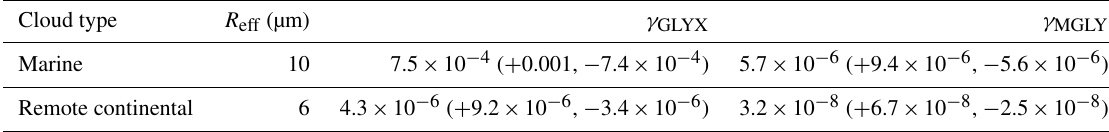
Table 3. Recommended γ for liquid cloud droplets. Cloud types and size as defined in GEOS-Chem v11. Cloud type